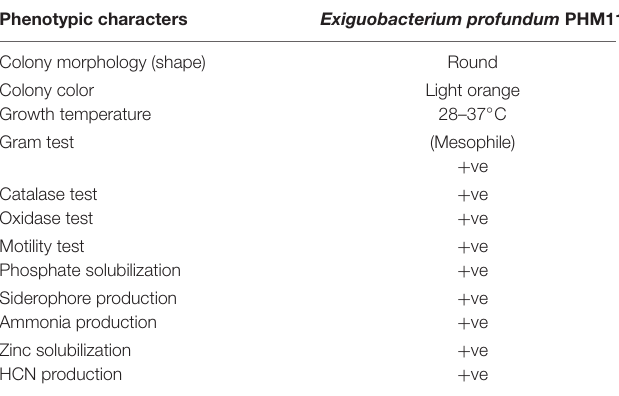
TABLE 1 | General and PGP traits of Exiguobacterium profundum